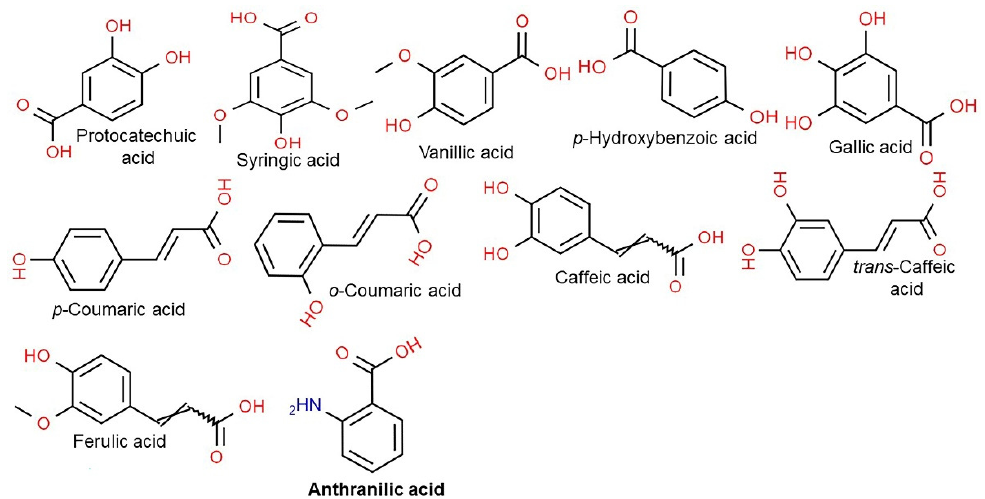
Figure 5. Chemical structure of vitamin E-derived tocopherol and tocotrienol isomers.